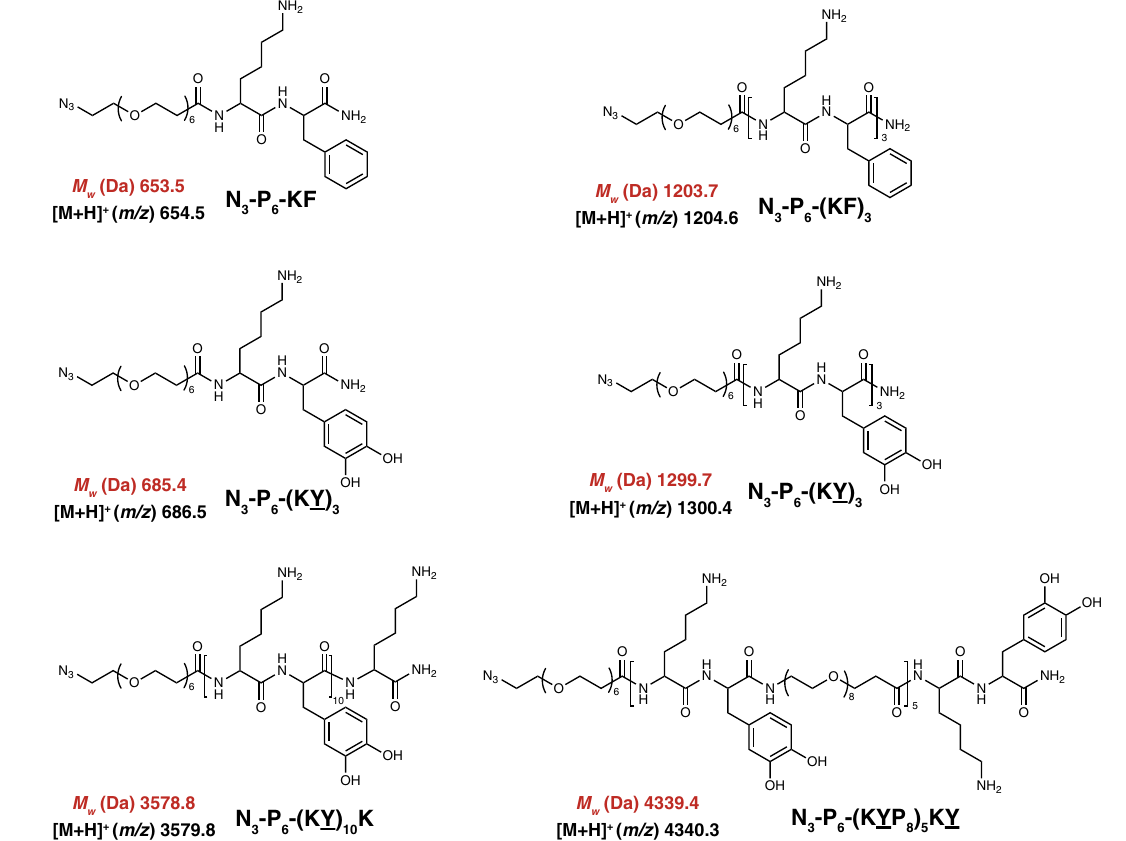
Fig. 2 Chemical structure of the synthesized peptides. Calculated exact mass and measured mass (obtained from MALDI) are shown in red and black,